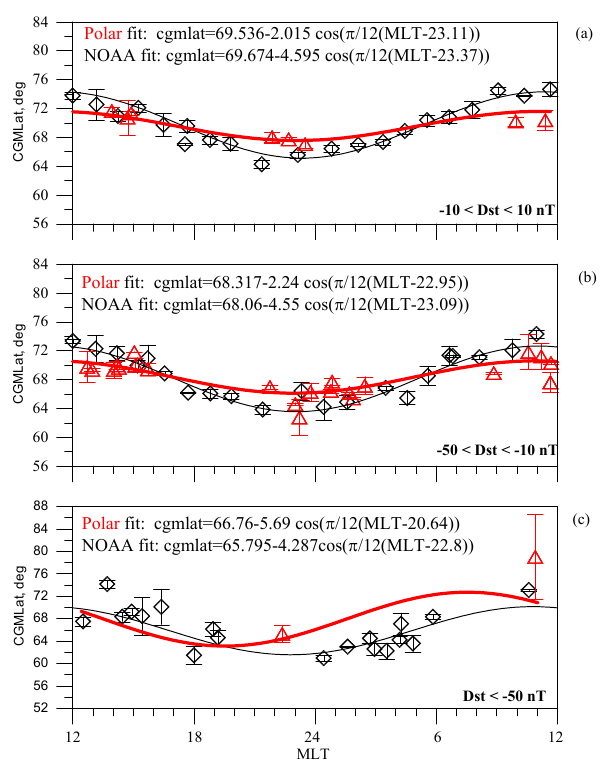
Fig. 5. Lat(MLT ) = A 0 − A 1 cos(π(MLT − MLT 0 )/ 12 ) ap- proximation for Polar IDB statistics (red curves) and NOAA IB statistics (black curves) ( a ) − 10nT <D st < 10nT, ( b ) − 50nT <D st < − 10nT, and ( c ) D st < − 50nT. Standard error means are shown by open red triangles for Polar data and by open black diamonds for NOAA